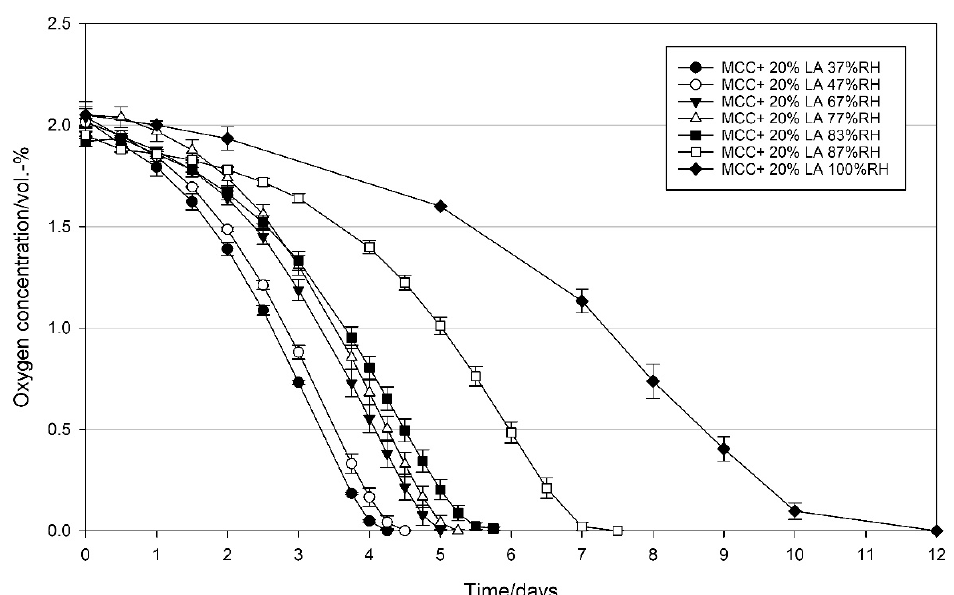
Figure 8. Oxygen concentration in packages containing 1 g modified calcium carbonate (MCC) loaded with 20 wt% linoleic acid stored at 21 °C, and 37–100% RH in the package. Packed under modified atmosphere (MAP, 2 vol.-% O 2 , rest N 2 ; loaded with 20 wt% linoleic acid stored at 21 ◦ C, and 37–100% RH in the package. Packed under headspace 250 mL). Mean values and standard deviation (n = 3). modified atmosphere (MAP, 2 vol.-% O 2 , rest N 2 ; headspace 250 mL). Mean values and standard deviation (n =